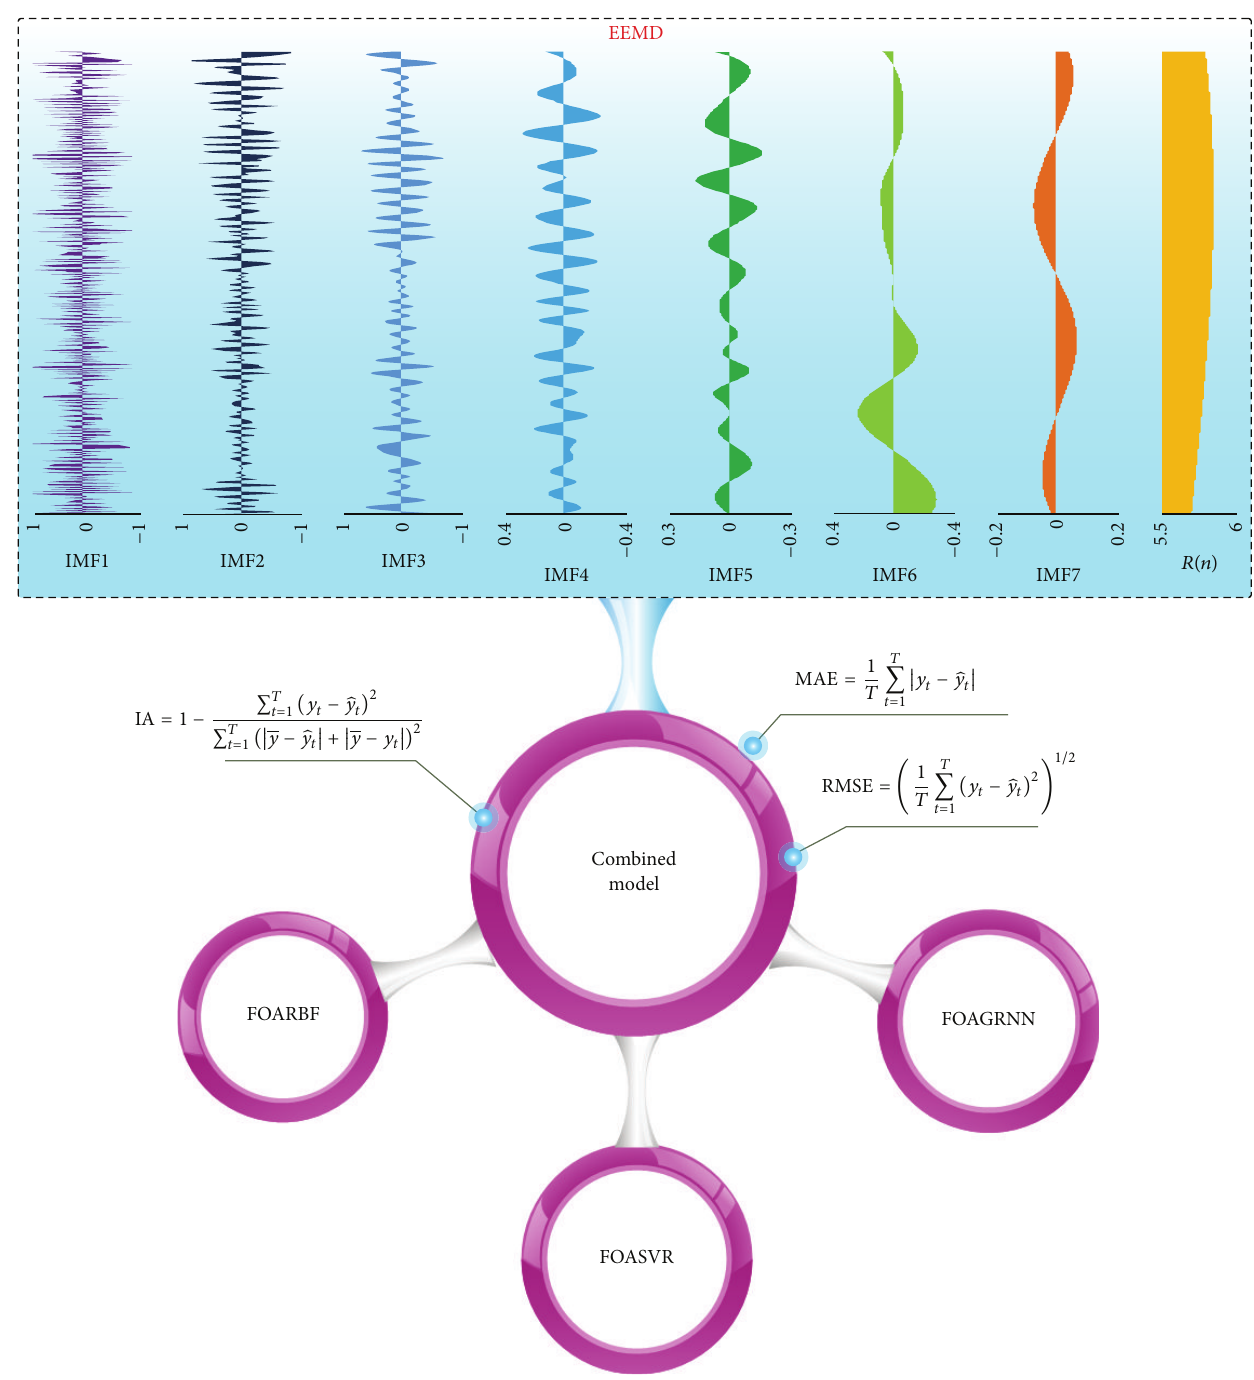
Figure 7: The process of the hybrid